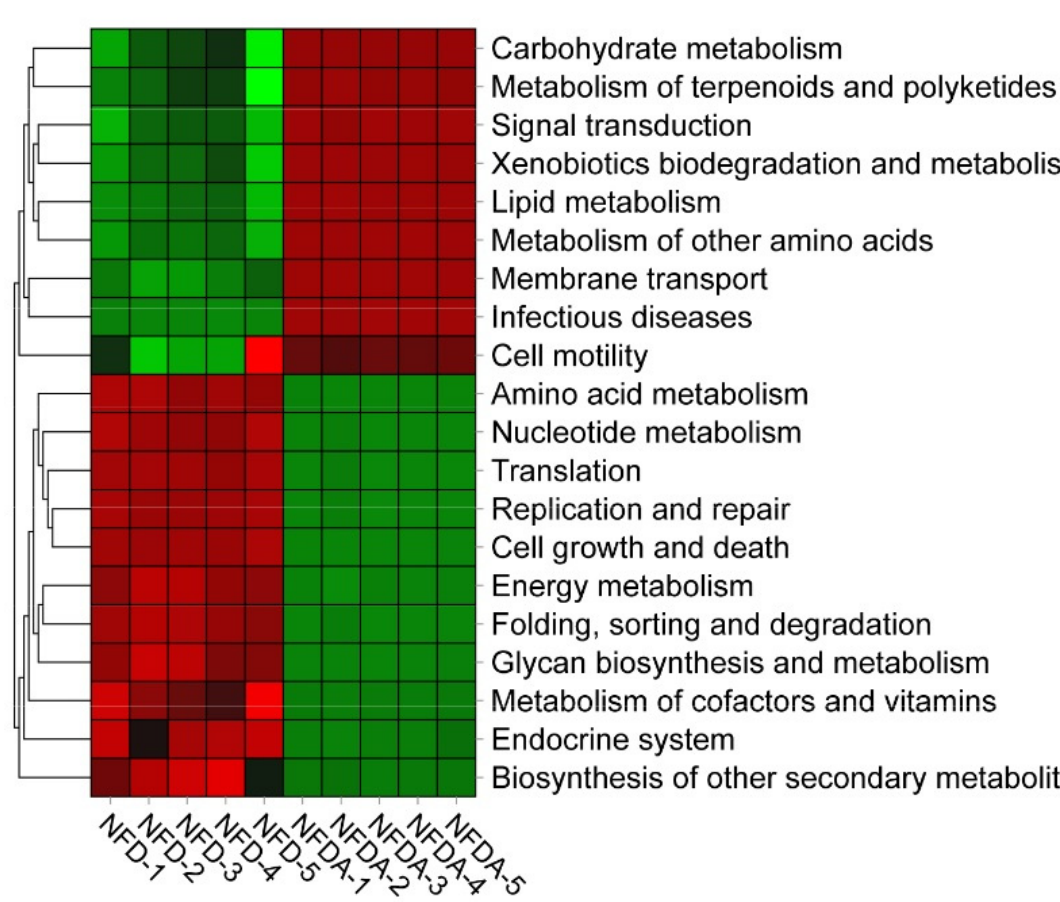
Figure 4. Prediction of the function of cecal microbiota. The red, dark and green colours represent enrichment degrees from high to low. NFD ( n = 5), NFDA ( n =